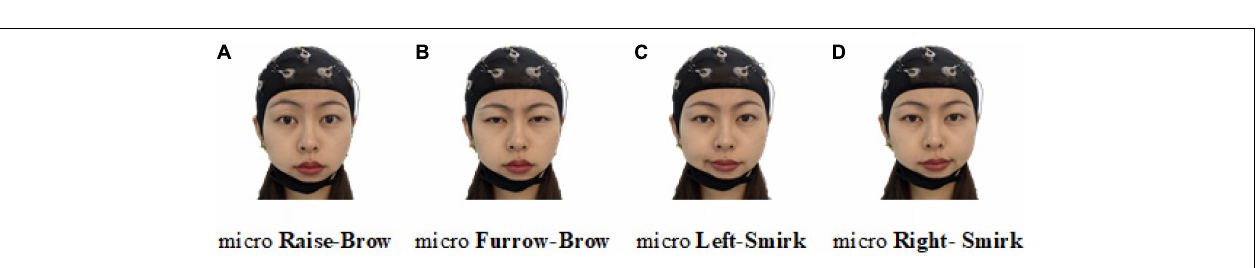
FIGURE 9 | The Neuracle wireless EEG acquisition system and its electrode placement, in which AFz is the ground and Cpz is the reference by default.